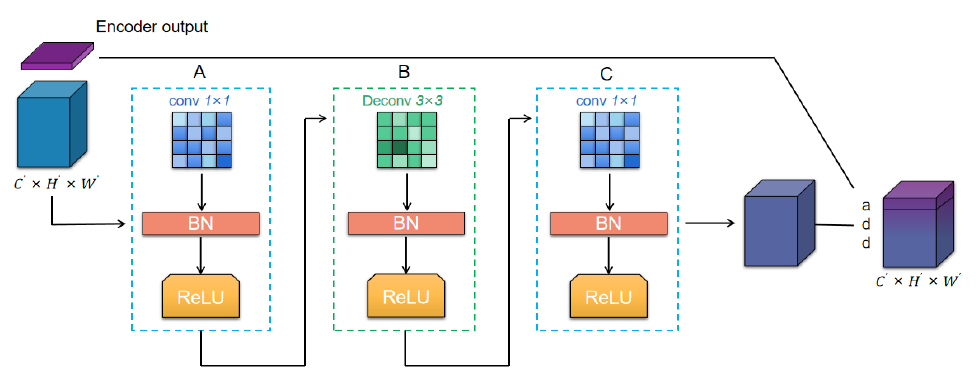
Figure 4. The overall structure of the decoder is composed of the connection of conv and deconv structures. The processing result is added with the output of the mirrored encoder.